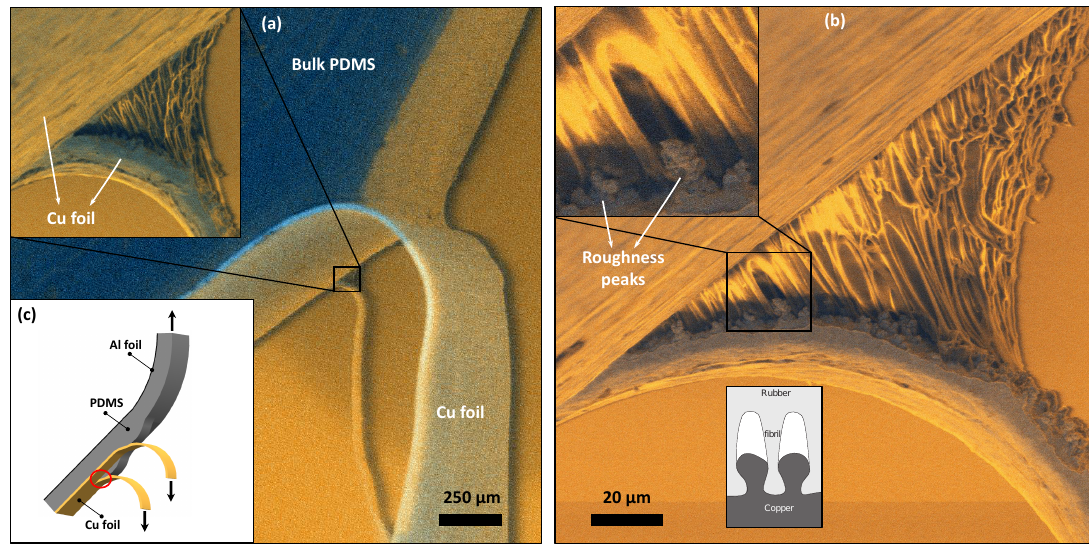
Figure 4. The alternative peel test: ( a ) two active peel fronts occur with the inset showing a detailed side view of the fibrillating PDMS; ( b ) close-up of the fibrillation front clearly indicating, for the first time, that initiation occurs at the roughness peaks while the PDMS is strongly anchored in the roughness valleys; ( c ) schematic of the alternative peel